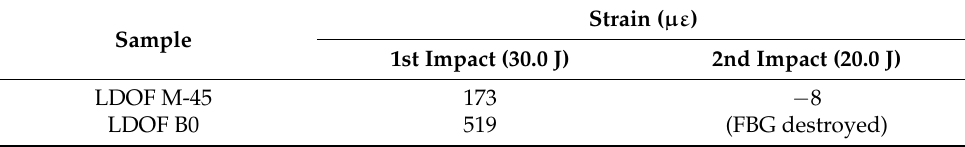
Table 3. Residual strains measured by embedded LDOF in each of the studied through-thickness locations after the first and second impacts. The impact location was on top of the FBG sensors.